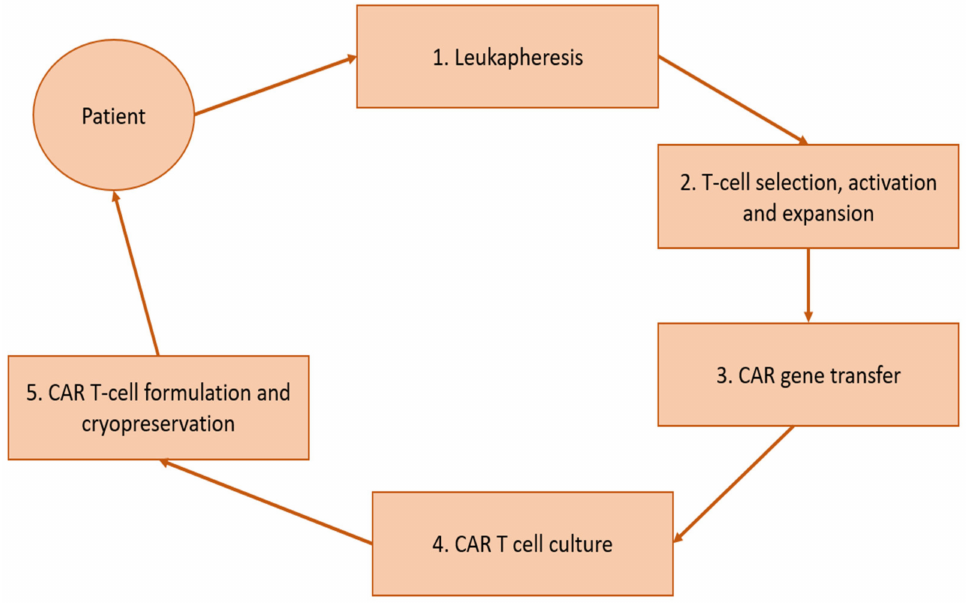
Figure 1. Summary of CAR-T formulation and